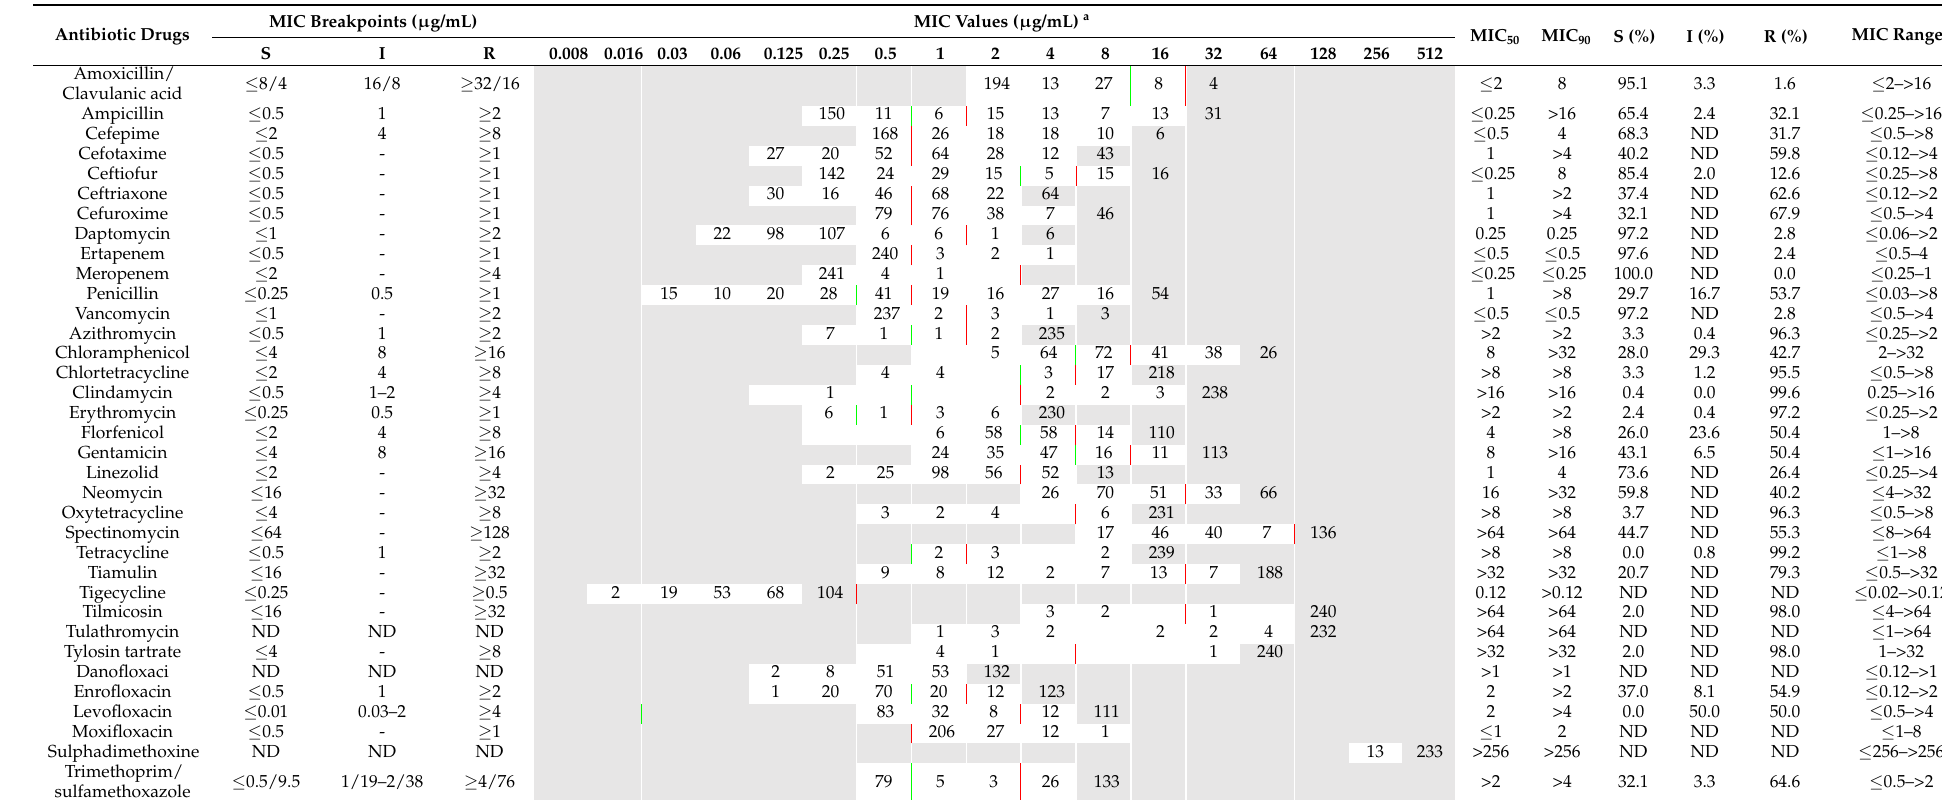
Table 2. Minimum inhibitory concentration (MIC) values distribution, MIC 50 and MIC 90 values, and resistance rates of S. suis strains from